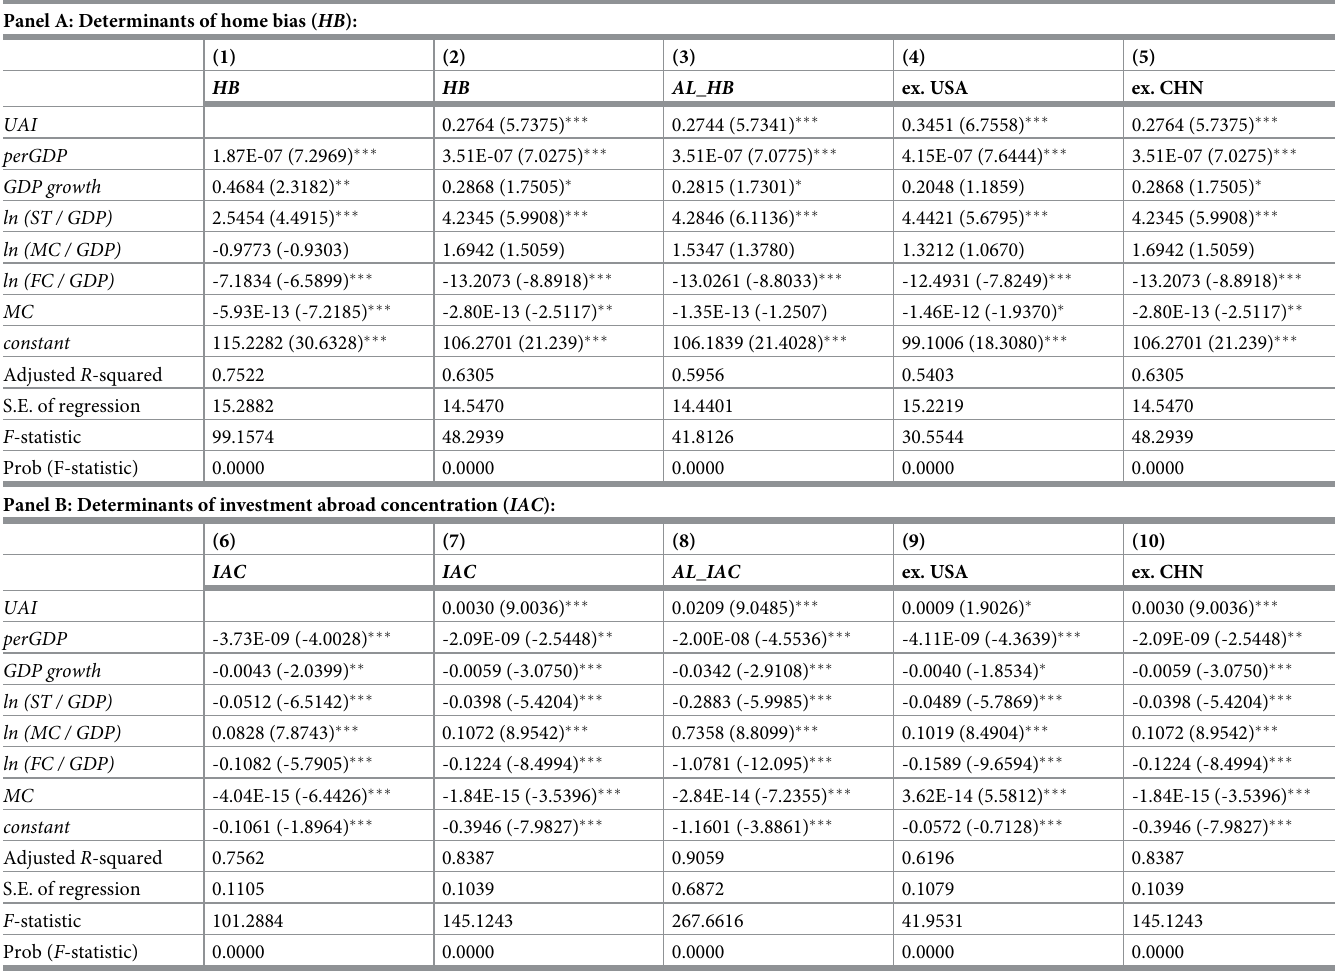
Table 4. The regression results of the UAI-UNDV